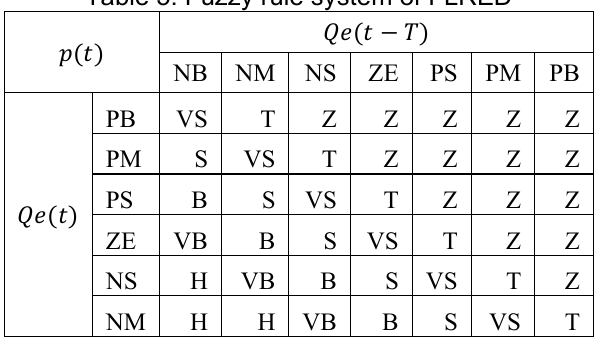
Table 5. Fuzzy rule system of FLRED